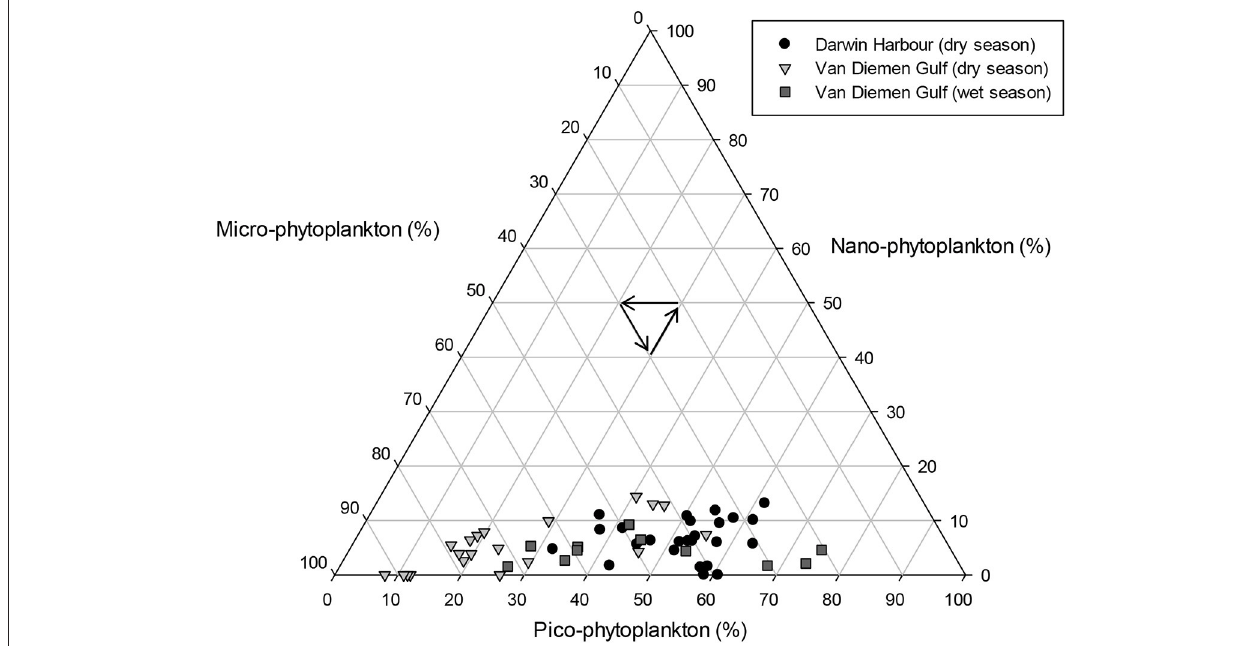
FIGURE 10 | Proportions of phytoplankton cell sizes for the Darwin Harbour dry ( N = 25), Van Diemen Gulf dry ( N = 20), and Van Diemen Gulf wet ( N = 11) samples. Size classes are defined as micro > 20 µ m, nano, 2–20 µ m, and pico, < 2 µ